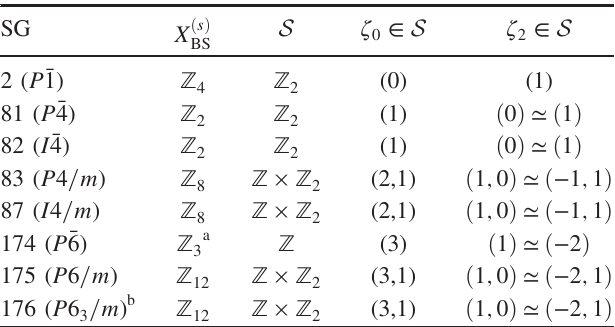
TABLE III. The bulk-surface correspondence for the key space denotes the symmetry-based indicator generated by a groups X ð s Þ BS strong topological insulator; S denotes the surface classification; ζ S , which is 0 denotes the generators of the subgroup of consistent with the trivial entry in X ð s Þ ; ζ 2 indicates representative BS surface signatures for the minimal doubled strong topological insulator, corresponding to the entry 2 ∈ X ð s Þ BS